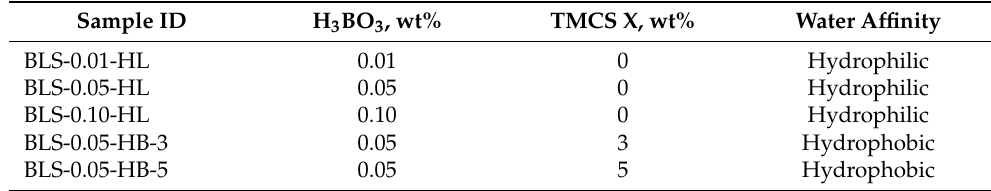
Table 1. Notation of the obtained BoronLightSil samples.